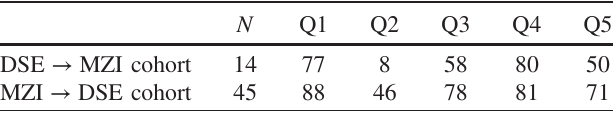
TABLE III. Percentage of graduate students from the DSE → MZI cohort and the MZI → DSE cohort who answered DSE polarizer questions Q1 through Q5 correctly on the DSE pretest. In the table, N refers to the number of graduate students in each cohort.